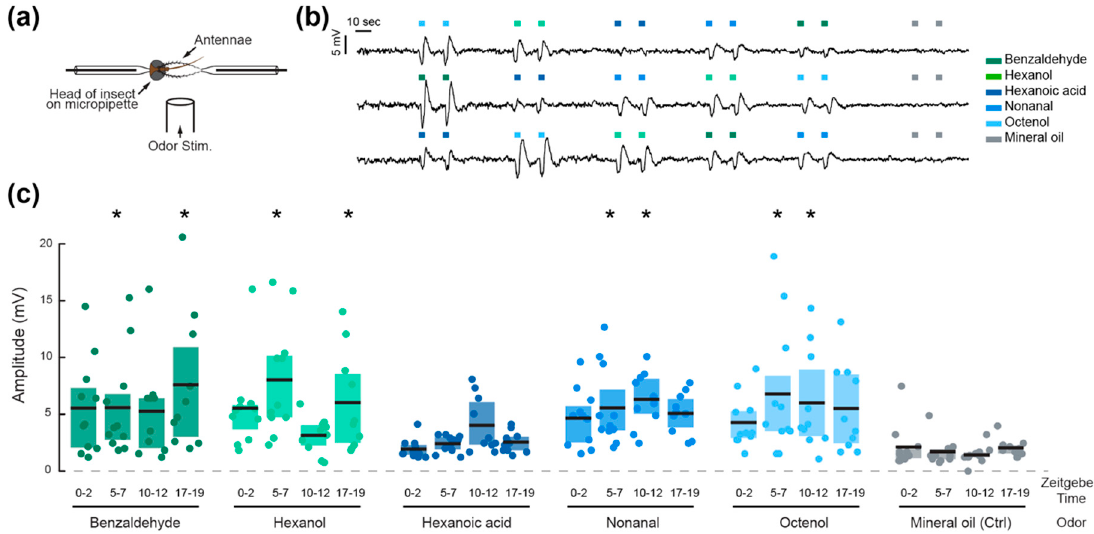
Figure 2. Olfactory sensitivity is time and odorant specific in adult Ae. aegypti females. ( a ) Schematic of the electrophysiological preparation for electroantennogram recordings. ( b ) Three representative traces depicting typical voltage deflection after olfactory stimulation of two consecutive pulses of five odorants, delivered in a randomized order. ( c ) Mean amplitude of the electrophysiological responses to the five odorants and mineral oil control at four different times of day. Each dot represents the response of an individual mosquito, black lines indicate the mean response at each time point, and shaded areas represent the first and last quartiles. Asterisks denote responses that are significantly different from the respective mineral oil control (Tukey post-hoc test, p <